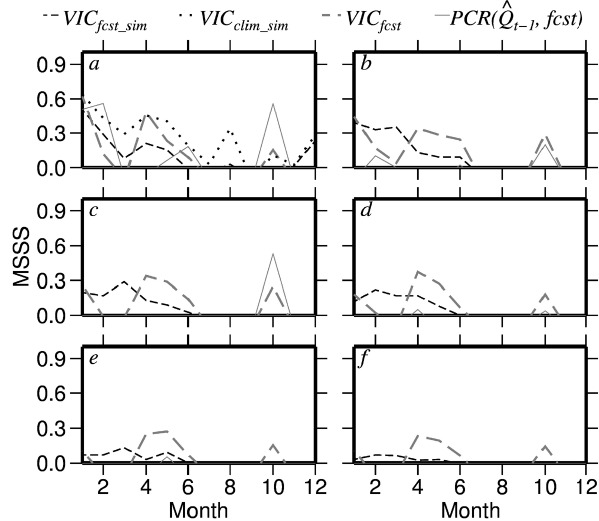
Fig. 4. Spearman rank correlations between estimated streamflow and observed streamflow at lead times 1 (a) to 6 (f) months. The horizontal gray line (at 0.38) indicates statistical significance cor- relation at 95% confidence interval. VIC fcst and VIC clim represent VIC model estimations when forced with ECHAM4.5 monthly pre- cipitation forecast and daily climatology ensembles, respectively. PCR( ˆ Q t − 1 , fcst) represents Principal Component Regression based on PCR with updated initial conditions (updated previous month’s streamflow for subsequent lead times). Sim indicates VIC simulated flow as reference streamflow.